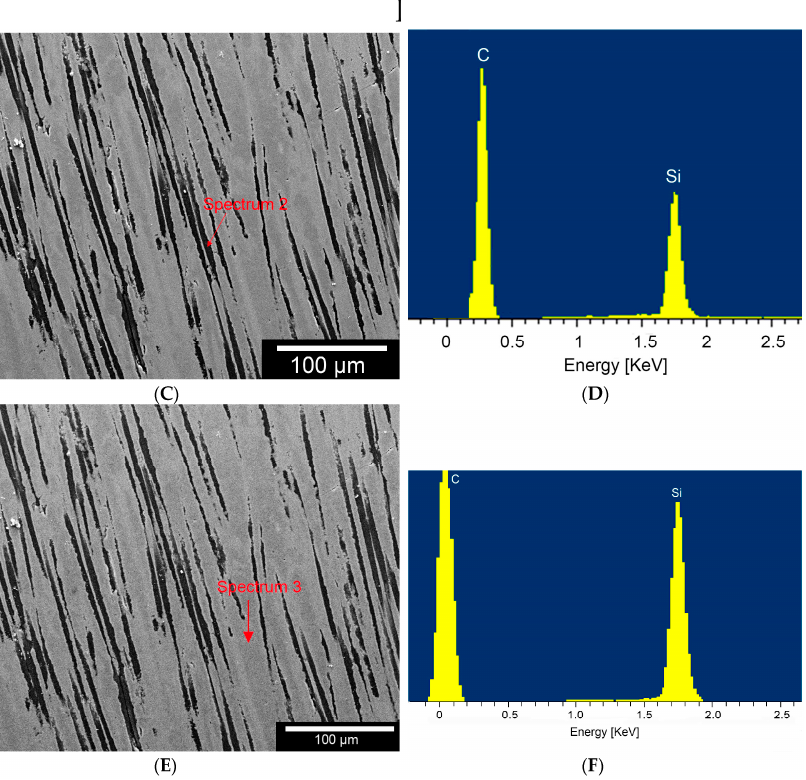
Figure 2. ESEM and EDX analysis of C/SiSiC-cubes, ESEM images taken with Fei Quanta 250 FEG with sensor for secondary electrodes, FEI, Hillsboro, OR, USA; ( A ): Overview of the different compositions of the sample, carbon fibres, SiC and Si; ( B ): EDX Spectrum of white area (see Figure 2A) mainly Si; ( C ): Higher magnification of Figure 2A, Arrow marks the area where the EDX spectrum (1) was taken; ( D ): EDX spectrum (2) of the Carbon Fibres; ( E ): higher magnification of Figure 2A and arrow marks where the EDX Spectrum was taken; ( F ): EDX spectrum (3) of SiC. Table 2. Spectrum characteristics of energy-dispersive X-ray spectriscopy.